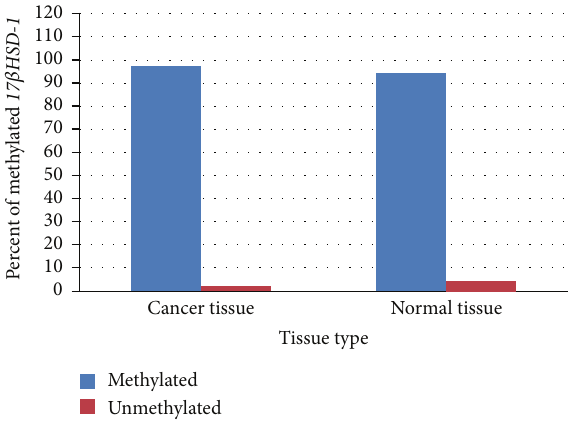
Figure 4: Difference between methylation status of 17 𝛽 HSD-1 promoter in cancer and normal tissue